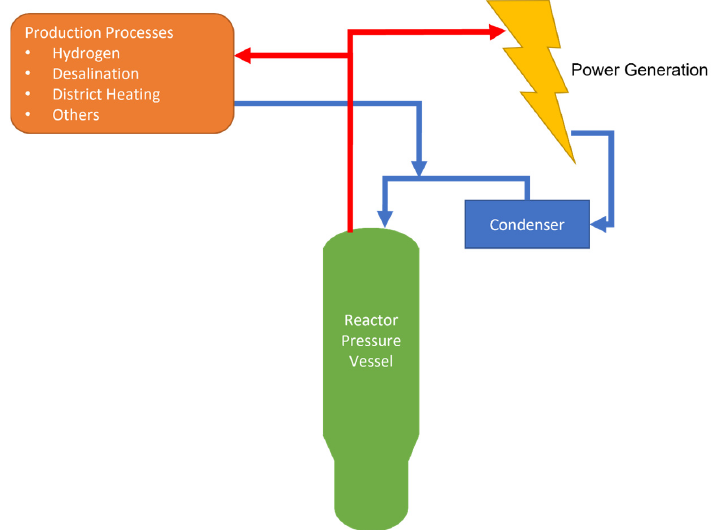
Figure 8. Schematic diagram of polygeneration with a SMR.